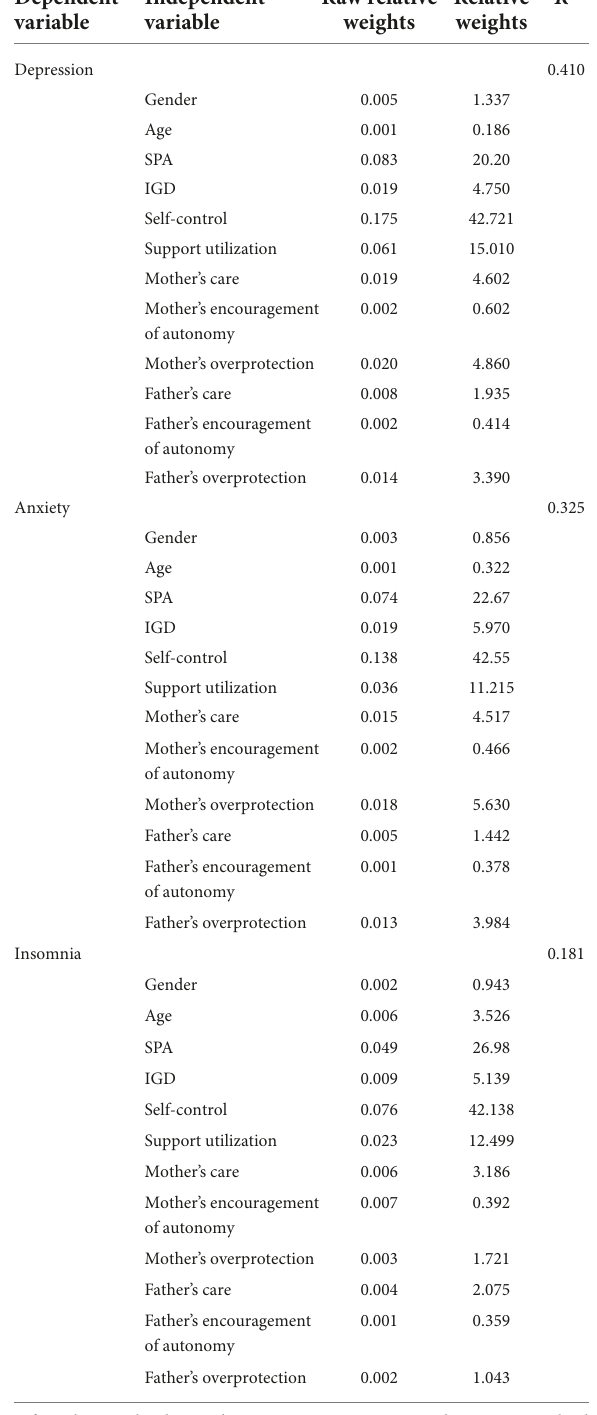
TABLE 5 Relative weight analysis on depression, anxiety and insomnia ( n =